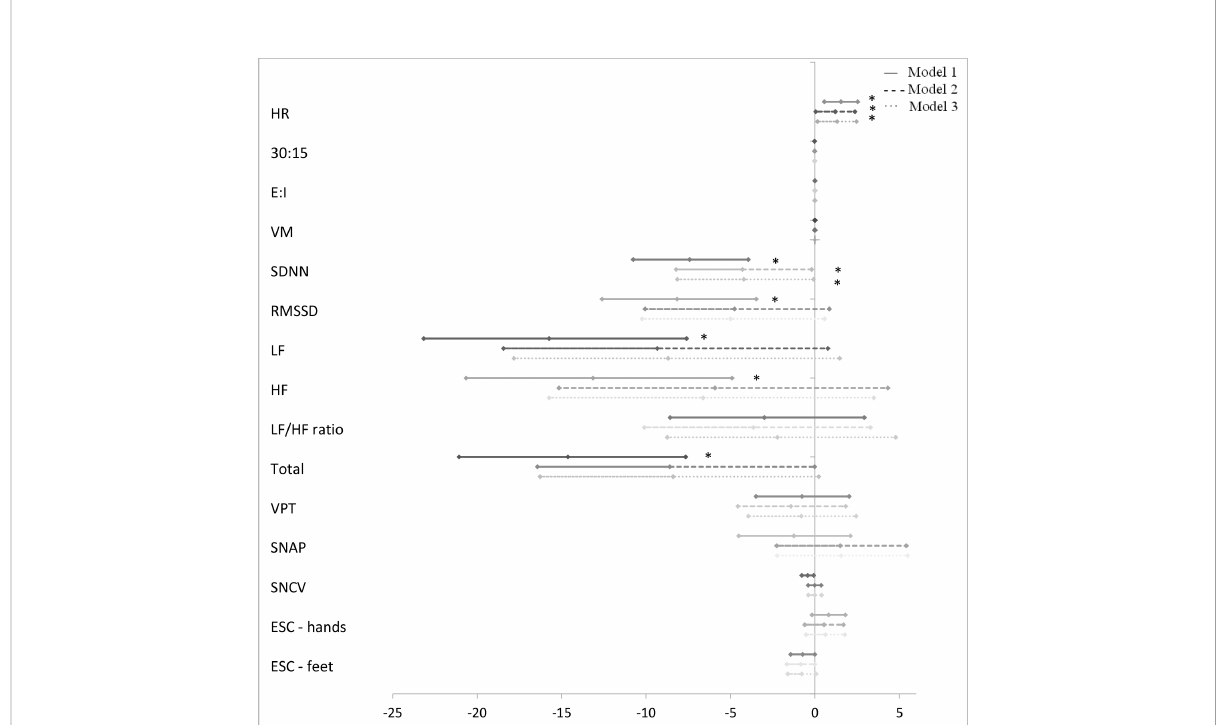
FIGURE 4 Forest plot of the associations between “ dicarbonyls ” and measures of diabetic neuropathy. Results are presented as estimates and 95% con fi dence intervals. Estimates show the percentage change in the outcomes for an increase of one unit of “ dicarbonyls ” . Studies with con fi dence interval crossing the vertical line are inconclusive. Model 1 adjusted for age and gender, model 2 adjusted as model 1 + diabetes duration and HbA 1c , and model 3 adjusted as model 2 + current smoking, total cholesterol, triglycerides, systolic blood pressure, and the use of beta blockers. CAN, cardiovascular autonomic neuropathy; HR, heart rate; 30:15, lying-to-standing test; E:I, deep breathing test; VM, Valsalva Manoeuvre; SDNN, standard deviation of normal-to-normal intervals; RMSSD, root mean square of the sum of the squares of differences between consecutive R-R intervals; LF, low-frequency power; HF, high-frequency power; DSPN, distal symmetric polyneuropathy; VPT, vibration perception threshold; SNAP, sural nerve amplitude potential; SNCV, sural nerve conduction velocity; ESC, electrochemical skin conduction. *p <